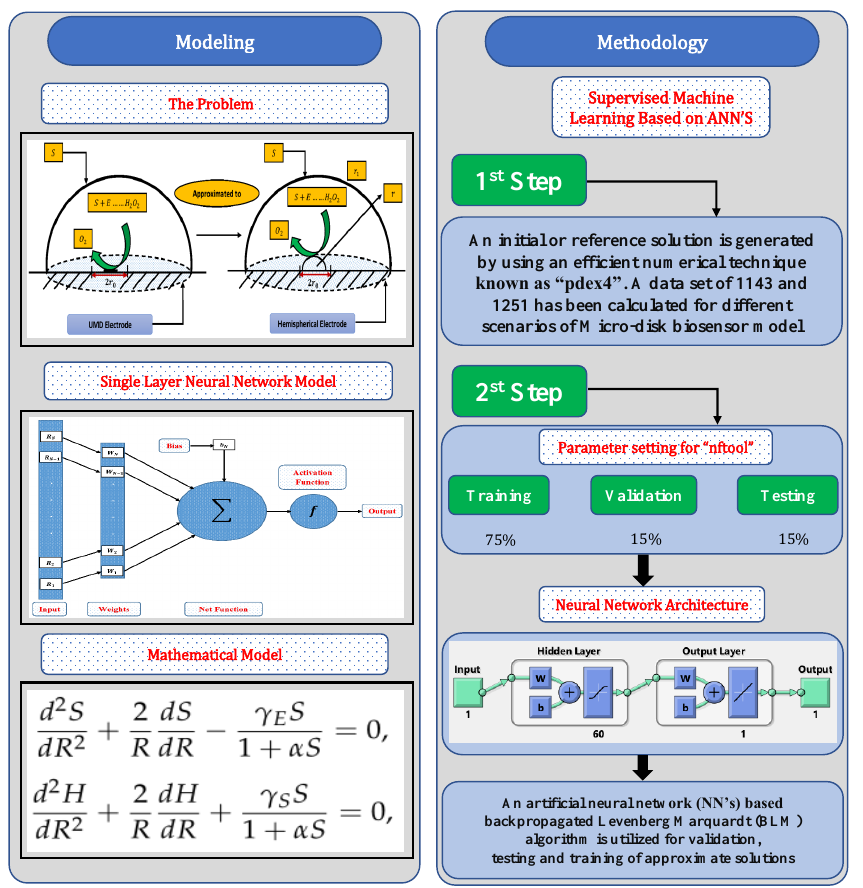
Figure 3. Working mechanism of design NNs–LM technique for numerical solution of mathematical model of micro-disk